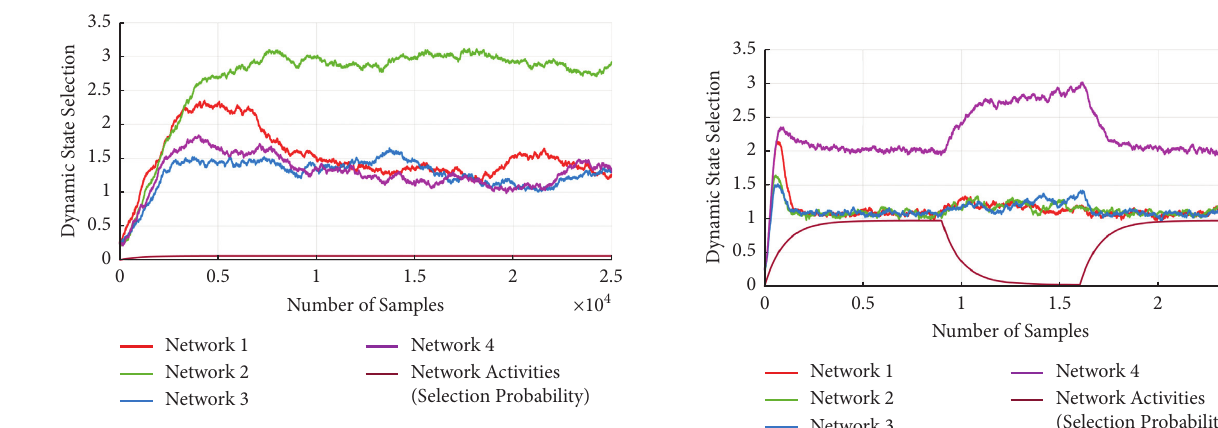
Figure 13: Effect of threshold on network connectivity for threshold � 2 ( S l � 0).